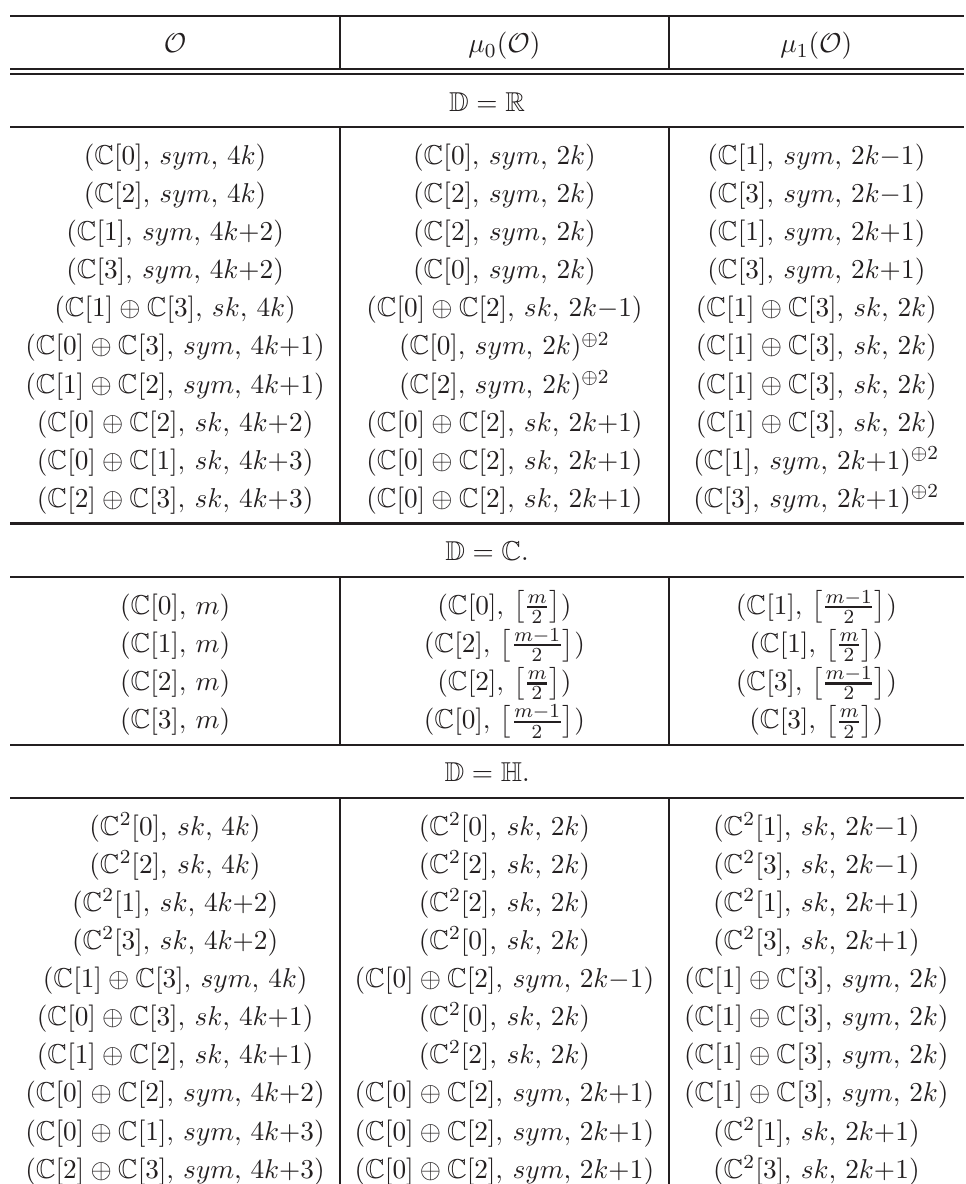
Table 4 Moment maps on indecomposable orbits in W +